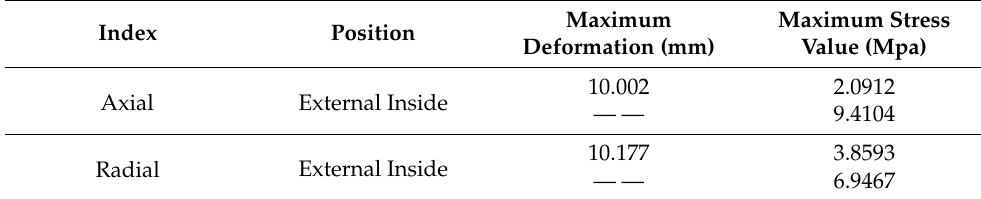
Table 3. Extrusion simulation results of fresh Camellia oleifera